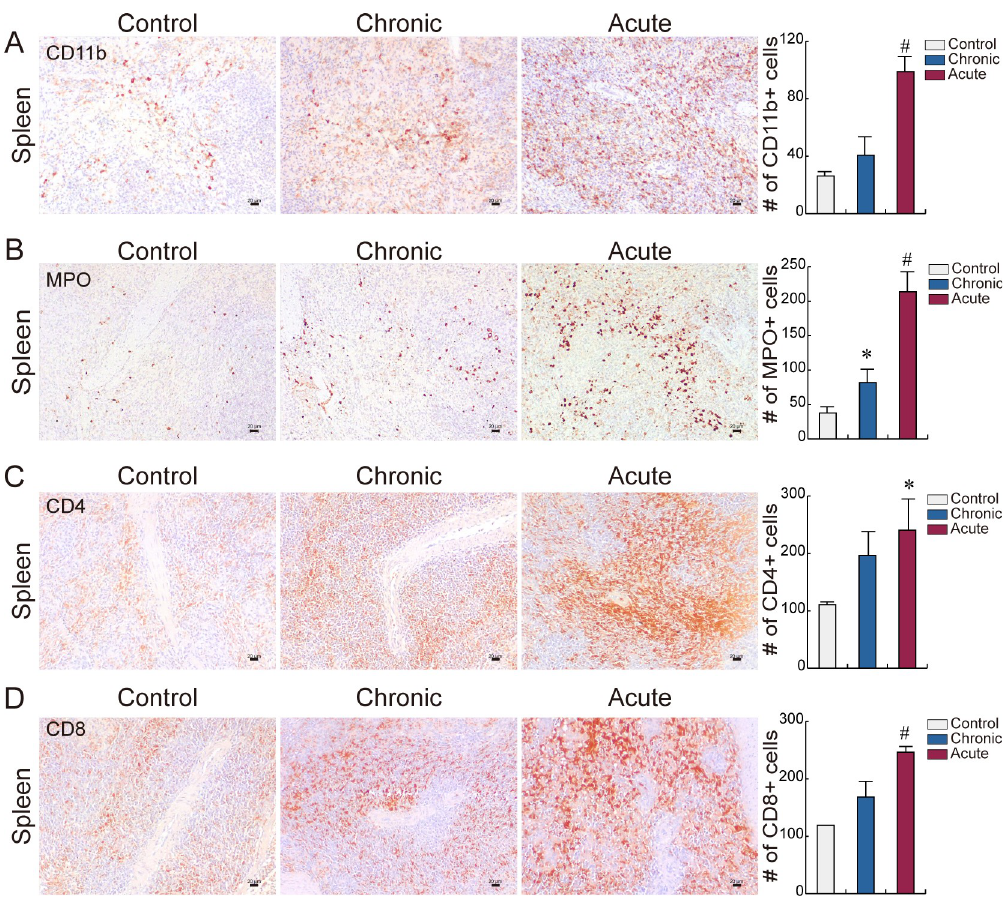
Fig 2. Immune cell distribution in spleen. (A–D) Immunohistochemistry. Population and distribution of (A) CD11b+ (macrophage), (B) MPO+ (neutrophil), (C) CD4+, and (D) CD8+ (lymphocyte) cells were examined in spleen. Representative images are shown; N � 3. Quantification of the immune cell number is shown as mean ± SD; # P < 0.01 relative to control, � P < 0.05 relative to control. Scale bar = 20 μ